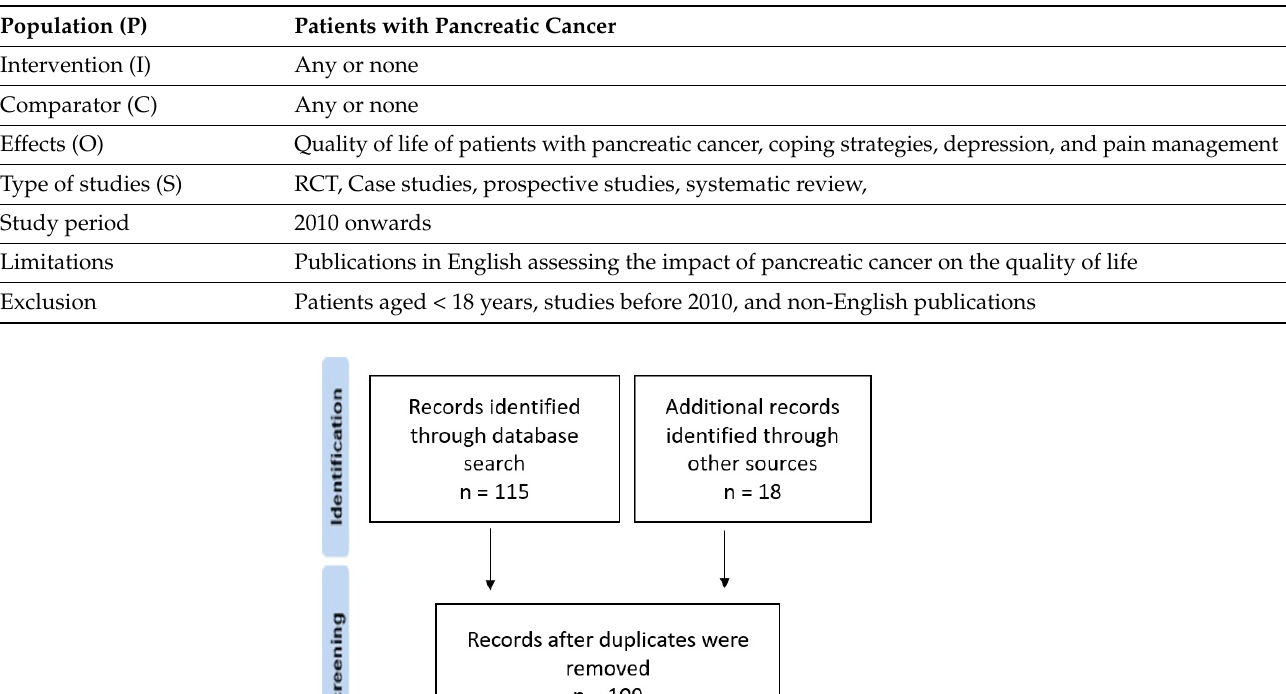
Table 2. Criteria for publication inclusion according to the PICOS scheme.